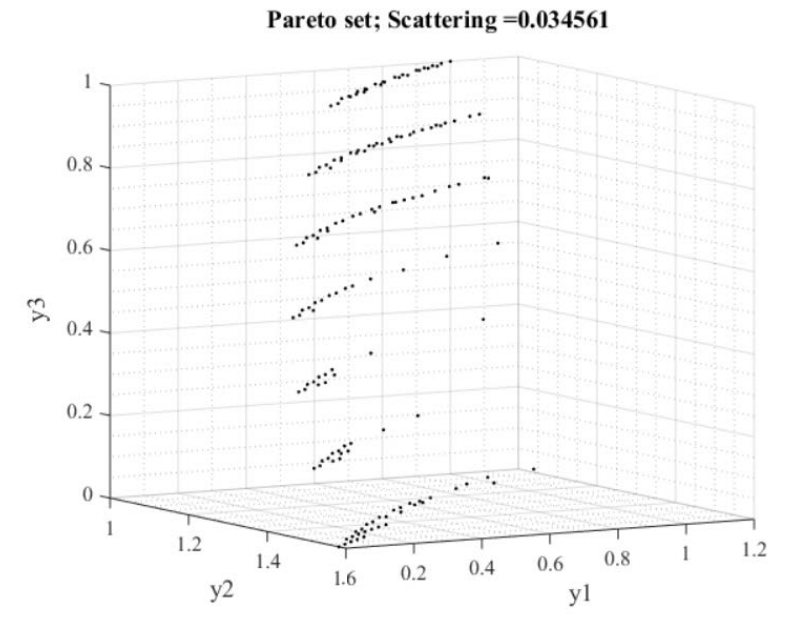
Figure 3. Three-dimensional plot of Pareto frontier—case-study